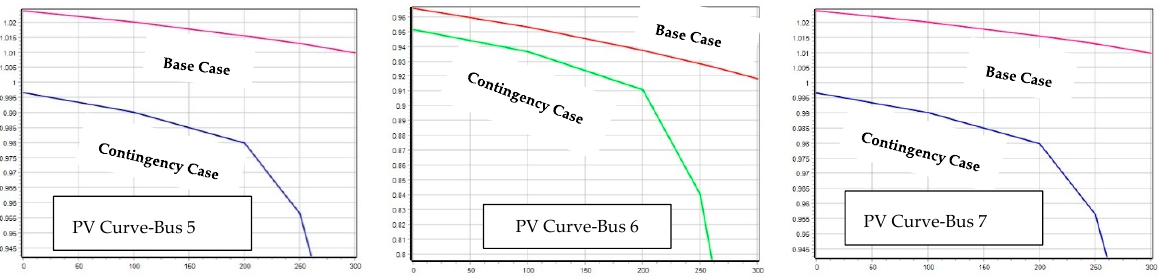
Figure 23. P-V curves of buses 5, 6, and Figure 23. P - V curves of buses 5, 6, and 7.